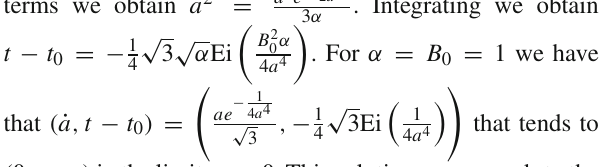
ration appears when Y = − 2 β (in Fig 2. β has been chosen equal to 1), and it is attained as a → a s :=